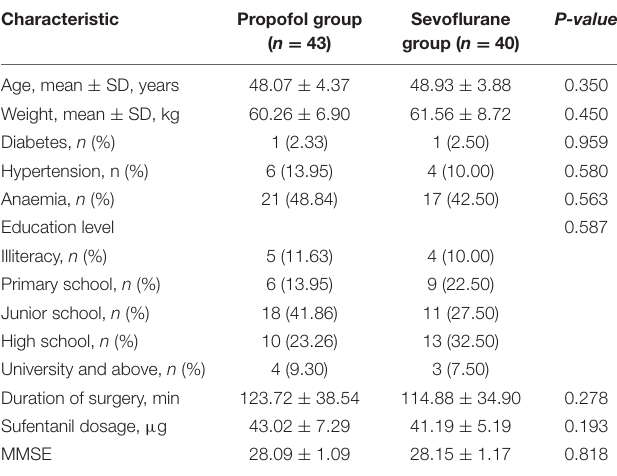
TABLE 1 | Demographic and baseline characteristics of patients.